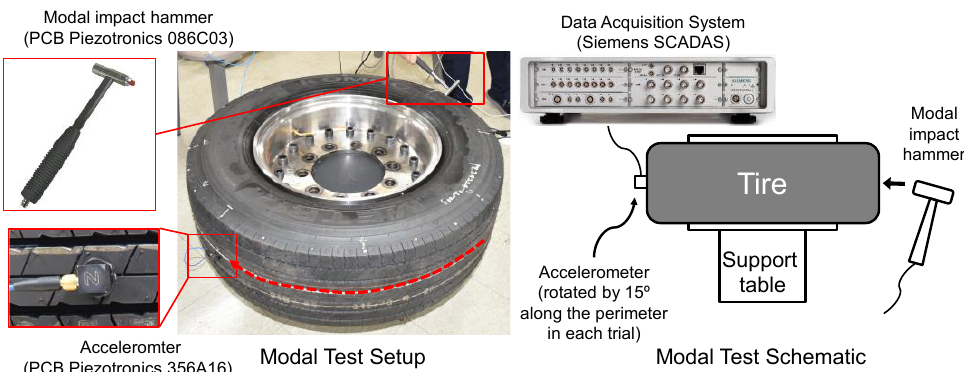
Figure 3. Modal test of physical tire using accelerometer and modal impact hammer.